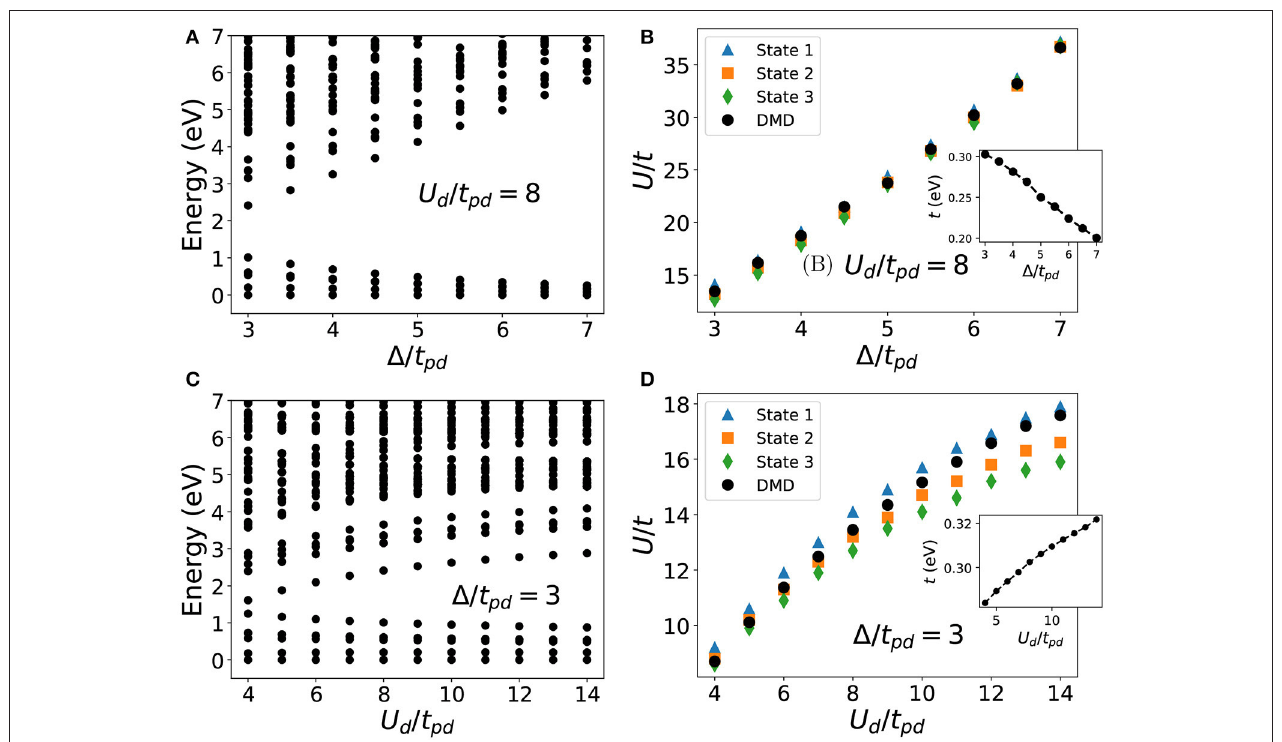
FIGURE 3 | Downfolding of a three-band Hubbard model to an effective one-band Hubbard model of d -like orbitals. (A,C) show the low energy spectra of the three-band model (relative to the corresponding ground state) for the cases of (A) fixed U d / t pd all cases, t pd is set to be 1.3 eV. (B,D) show the downfolded parameters for the one-band model corresponding to the three-band parameter choices in (A,C) , respectively. The one-band U / t values were obtained either by comparing h˜ d † 1 ˜ d 2 using the lowest three eigenstates. The insets show t obtained from